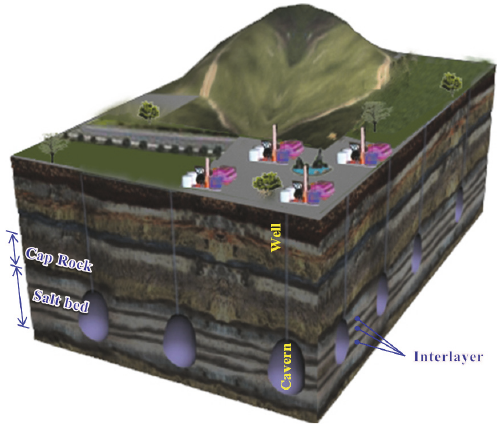
Figure 1: Illustration of salt cavern oil storages in a bedded salt